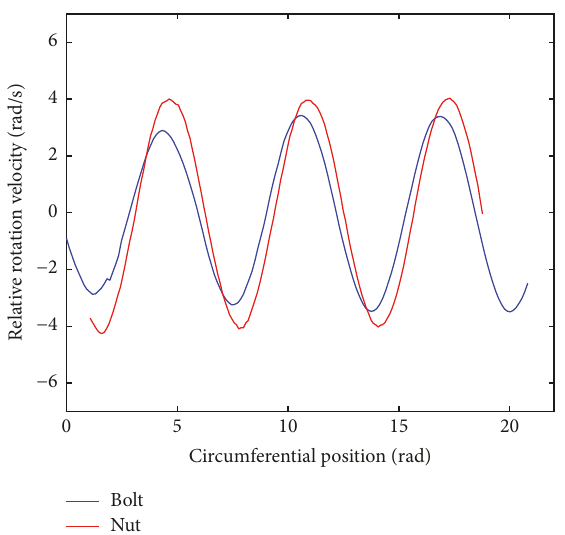
Figure 24: The position-velocity fields of bolt and nut at 0.25